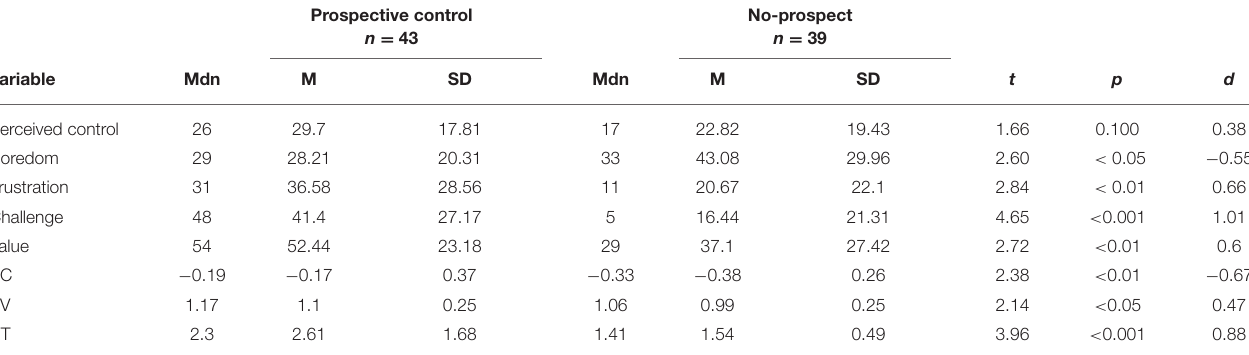
TABLE 4 | Descriptive statistics for all variables and conditions, and independent samples comparisons, associated significance levels and effect sizes (Study